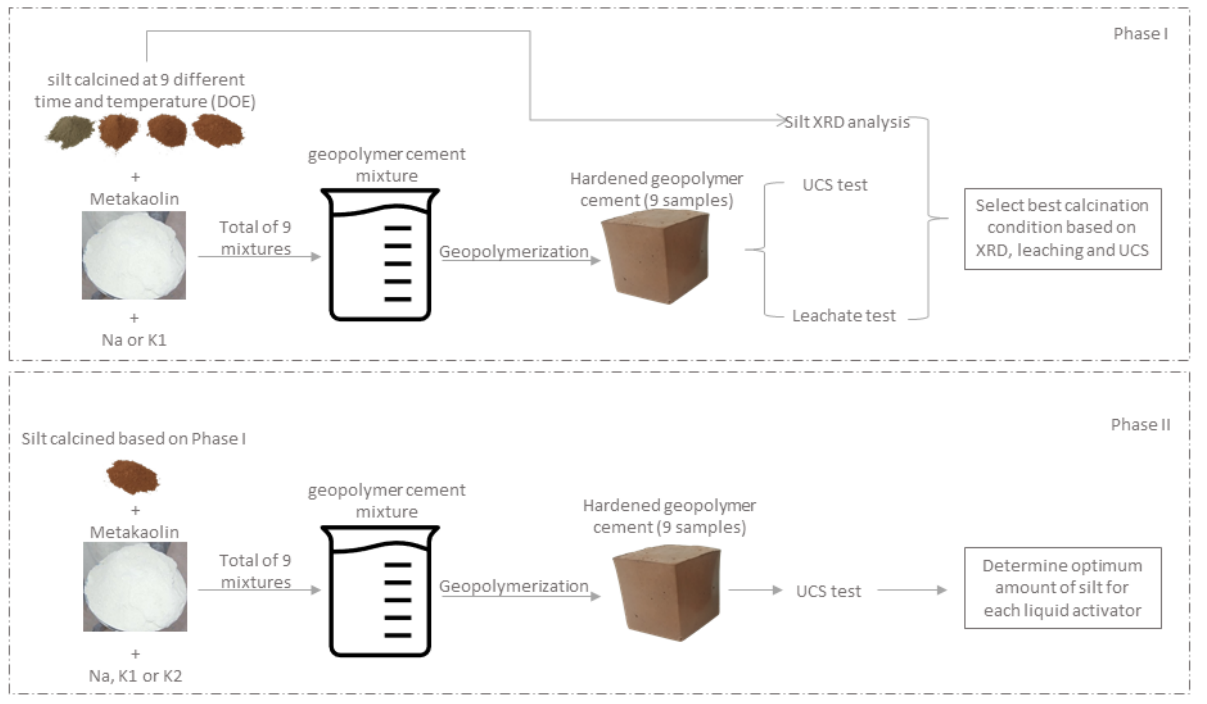
Figure 1. Methodology flow chart.